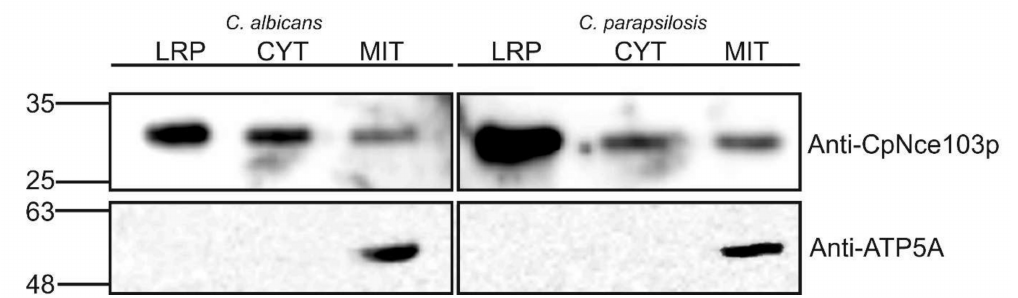
Figure 3. Western blot analysis of CA presence in C. albicans and C. parapsilosis mitochondrial (MIT) and cytosolic fractions (CYT), and in the fraction obtained by the lyticase treatment of the cell was (LRP). Polyclonal anti-CpNce103p antibodies (upper panel) and anti-ATP5A antibodies (lower panel) were used for the